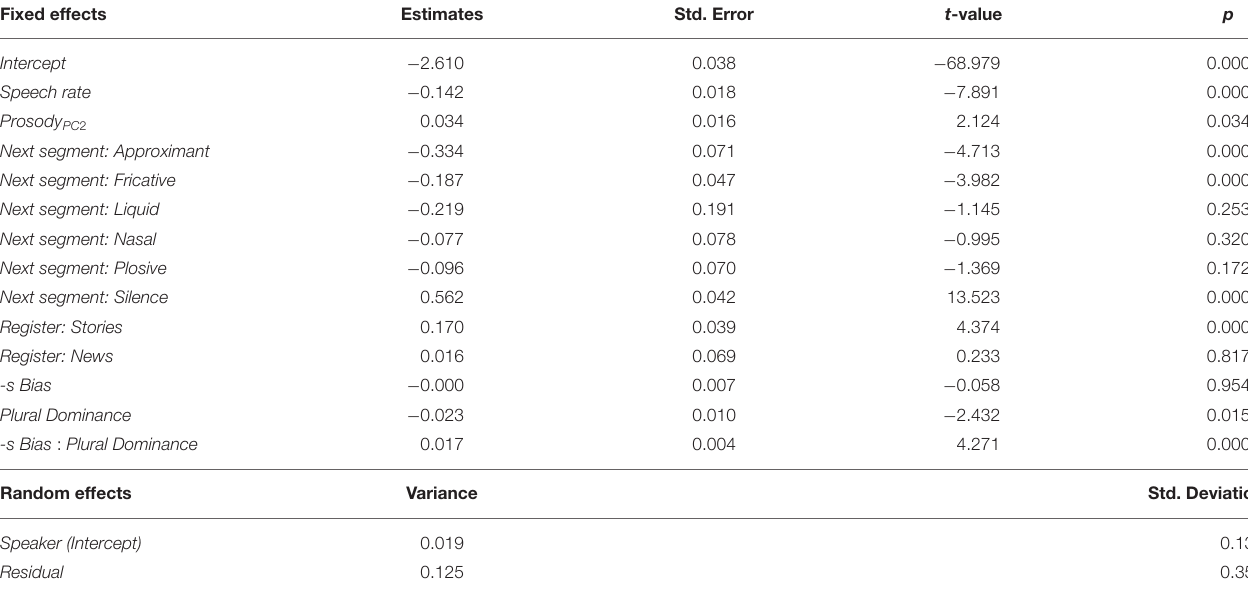
TABLE 5 | Mixed effects model of -s